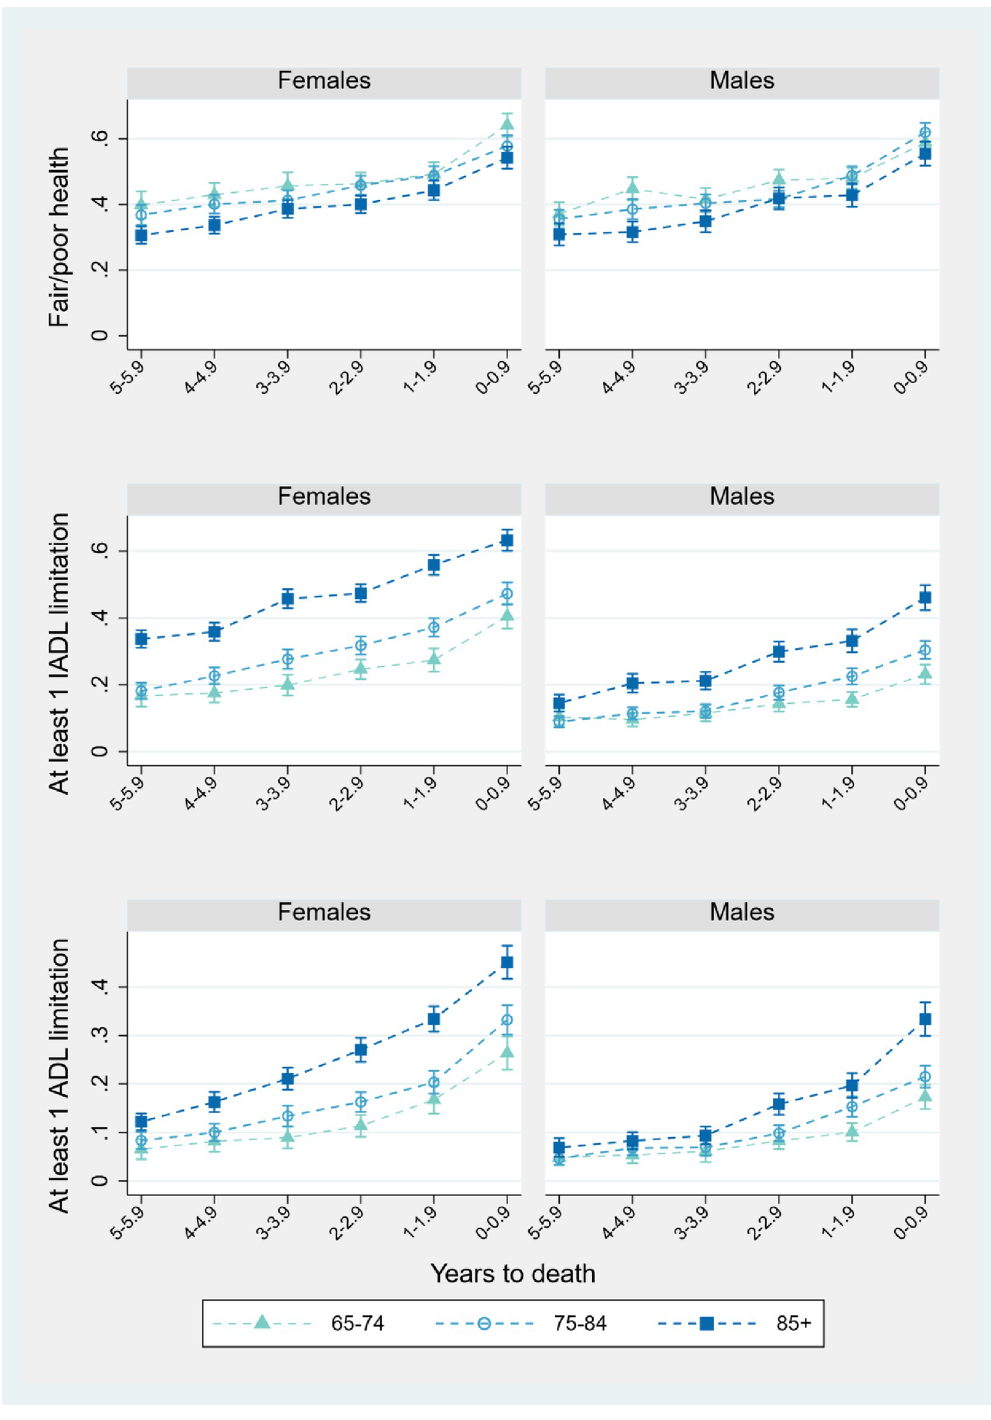
Fig 2. Proportion of population in given health state across final years of life, by age at death (with 95% confidence intervals).